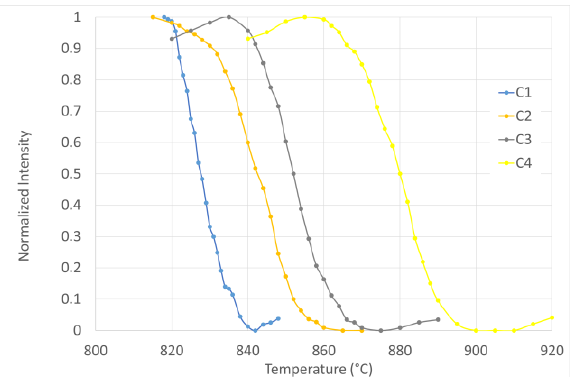
Figure 6. Follow-up of the opacification of the parent glasses with the rise in temperature by mean of the optical dilatometer. Curves show the variation in the normalized transmitted intensity. Table 2. Properties of the parent glasses C1, C2, C3 and C4.